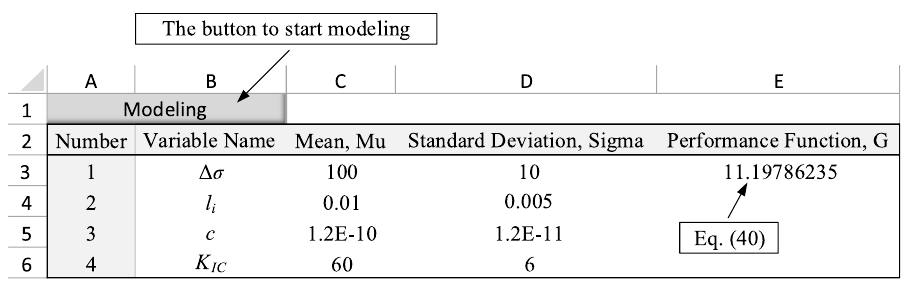
Fig 5. Data entry table in the spreadsheet for the example 2.